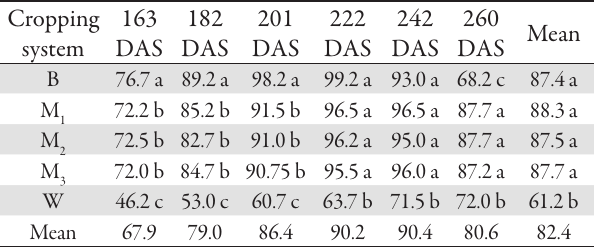
B=sole bean; M1: alternate-row intercrop; M2: within-row intercrop; M3: mixed intercrop; W = sole wheat DAS=Day after seeding LSD for main effect of cropping